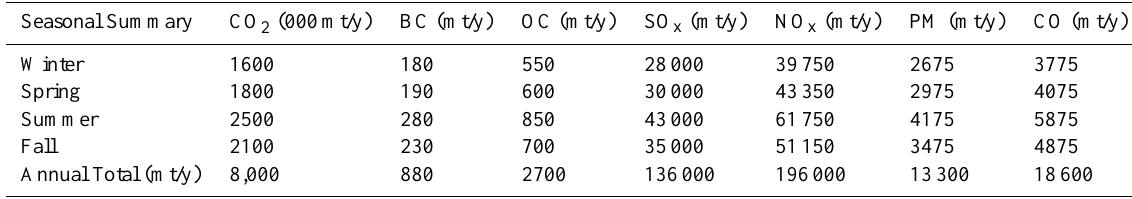
Table 4. Seasonal emissions of in-Arctic ship traffic for 2004.